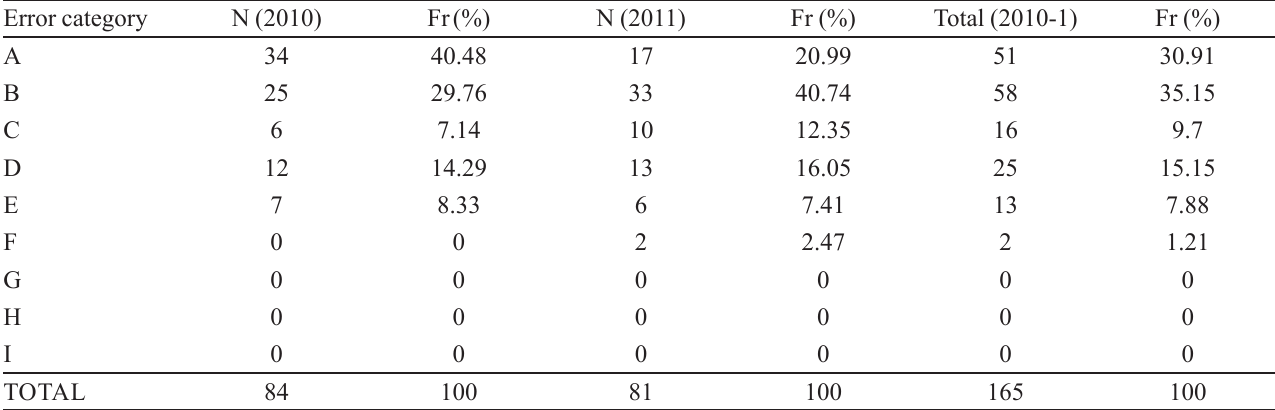
TABLE I - Seriousness classification for medication errors according to the National Coordinating Council for Medication Error Reporting and Prevention (NCCMERP), HCPA, 2010 - 2011